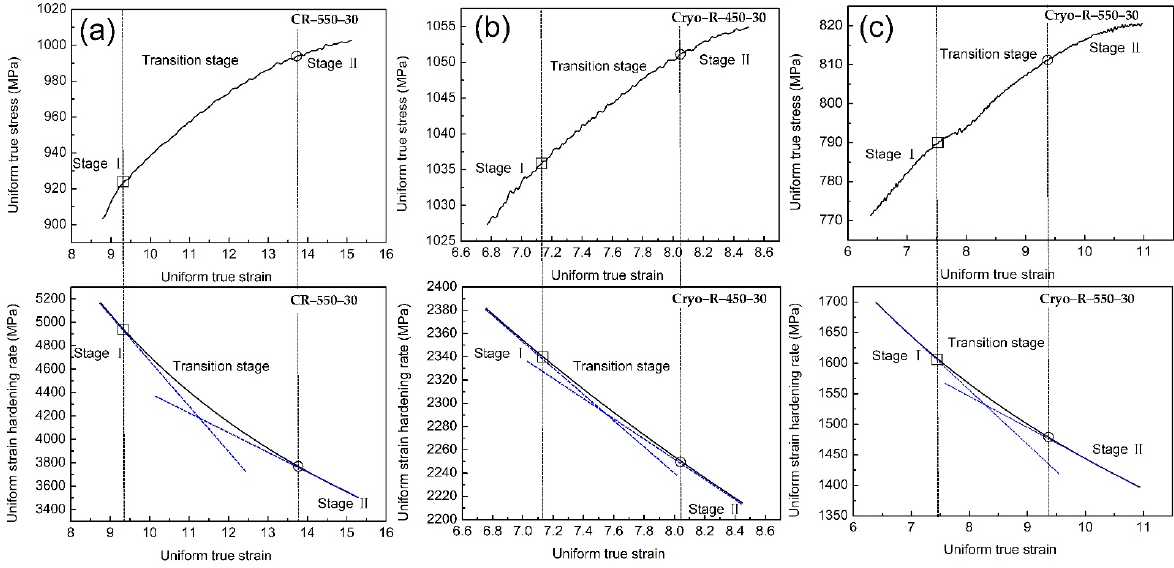
Figure 8. Sectional diagram of work hardening curves during uniform plastic deformation in spec ‐